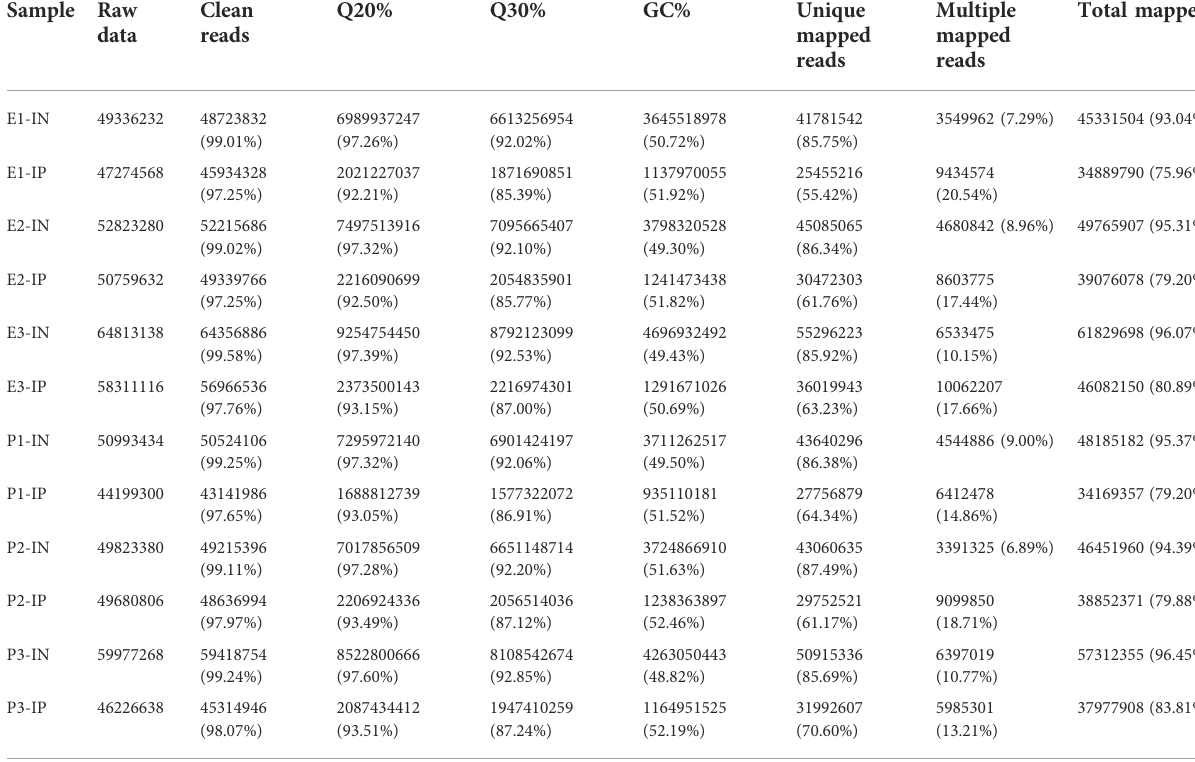
TABLE 1 Comparison of the quality of sequencing data and the reference genome between the two libraries. Sample Raw